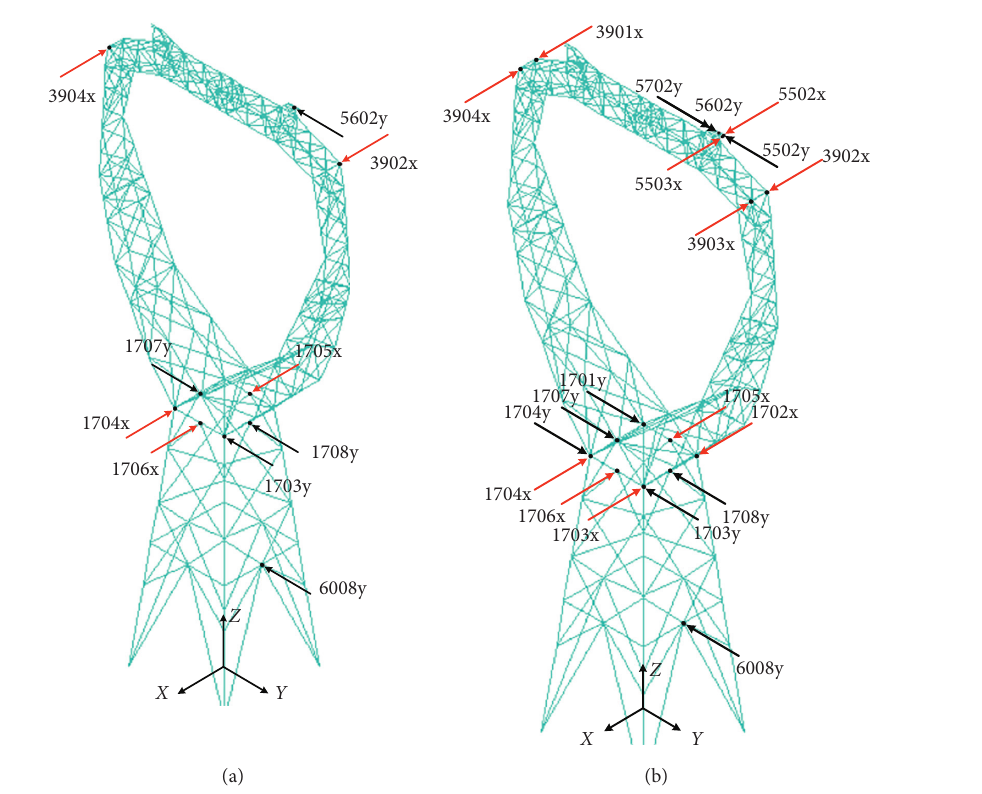
Figure 6: Locations of different numbers of sensors. (a) 10 sensors. (b) 20 sensors.